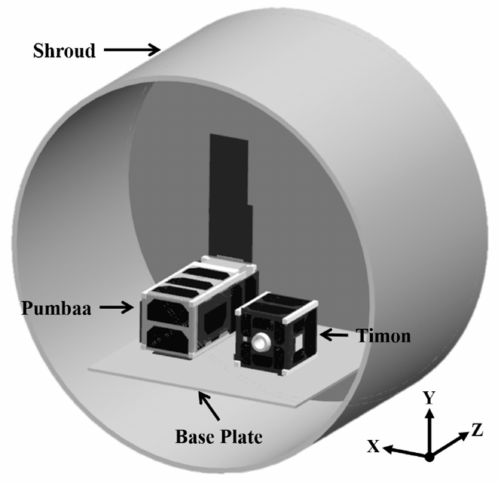
Figure 22. Duplicated thermal vacuum chamber and the CubeSats for the correlation of the TVCT